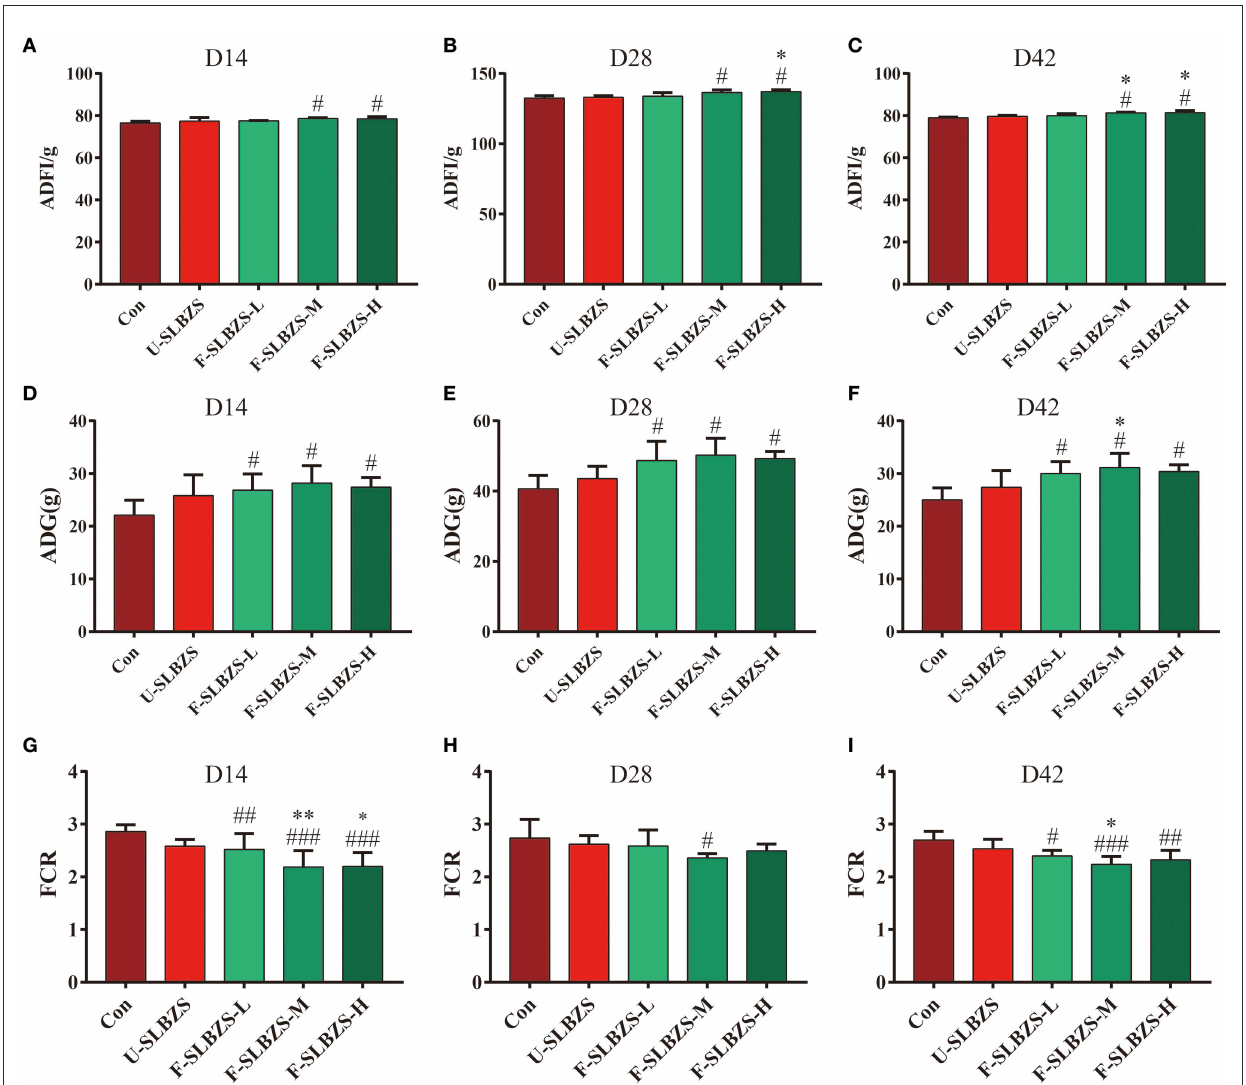
FIGURE2 Effects of fermented SLBZS on growth performance of broilers. (A) ADFI of broilers in the second stage. (B) ADFI of broilers in the third stage. (C) ADFI of broilers in the whole stage. (D) ADG of broilers in the second stage. (E) ADG of broilers in the third stage. (F) ADG of broilers in the whole stage. (G) FCR of broilers in the second stage. (H) FCR of broilers in the third stage. (I) FCR of broilers in the whole stage. Bars represent mean values ± SD ( n = 3 for ADFI, n = 4–6 for ADG and FCR). # , ## , and ### indicate p < 0.05, p < 0.01 and p < 0.001 compared with the Con group, * and ** indicate p < 0.05 and p < 0.01 compared with the U-SLBZS